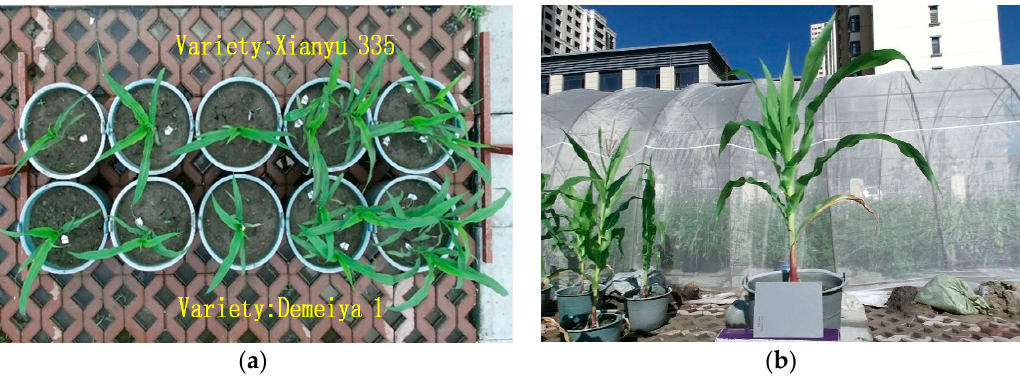
Figure 7. Maize plants under the pot cultivation method. ( a ) A representative sample set of maize plants ( b ) An individual plant.